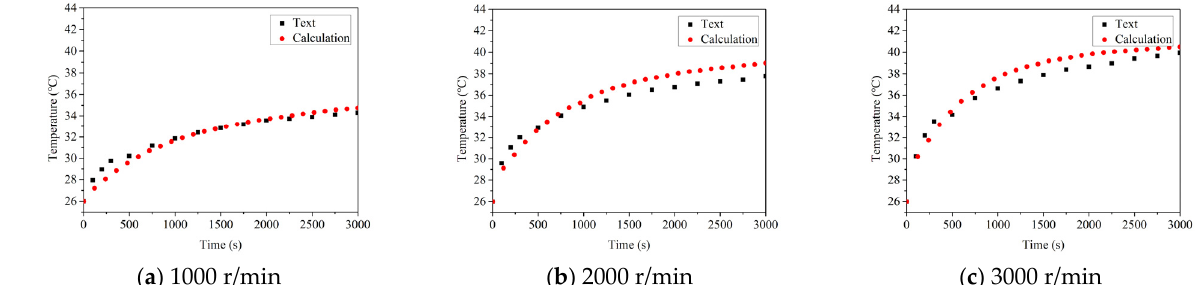
Figure 8. The influence of the speed on temperature change of complete bearing.